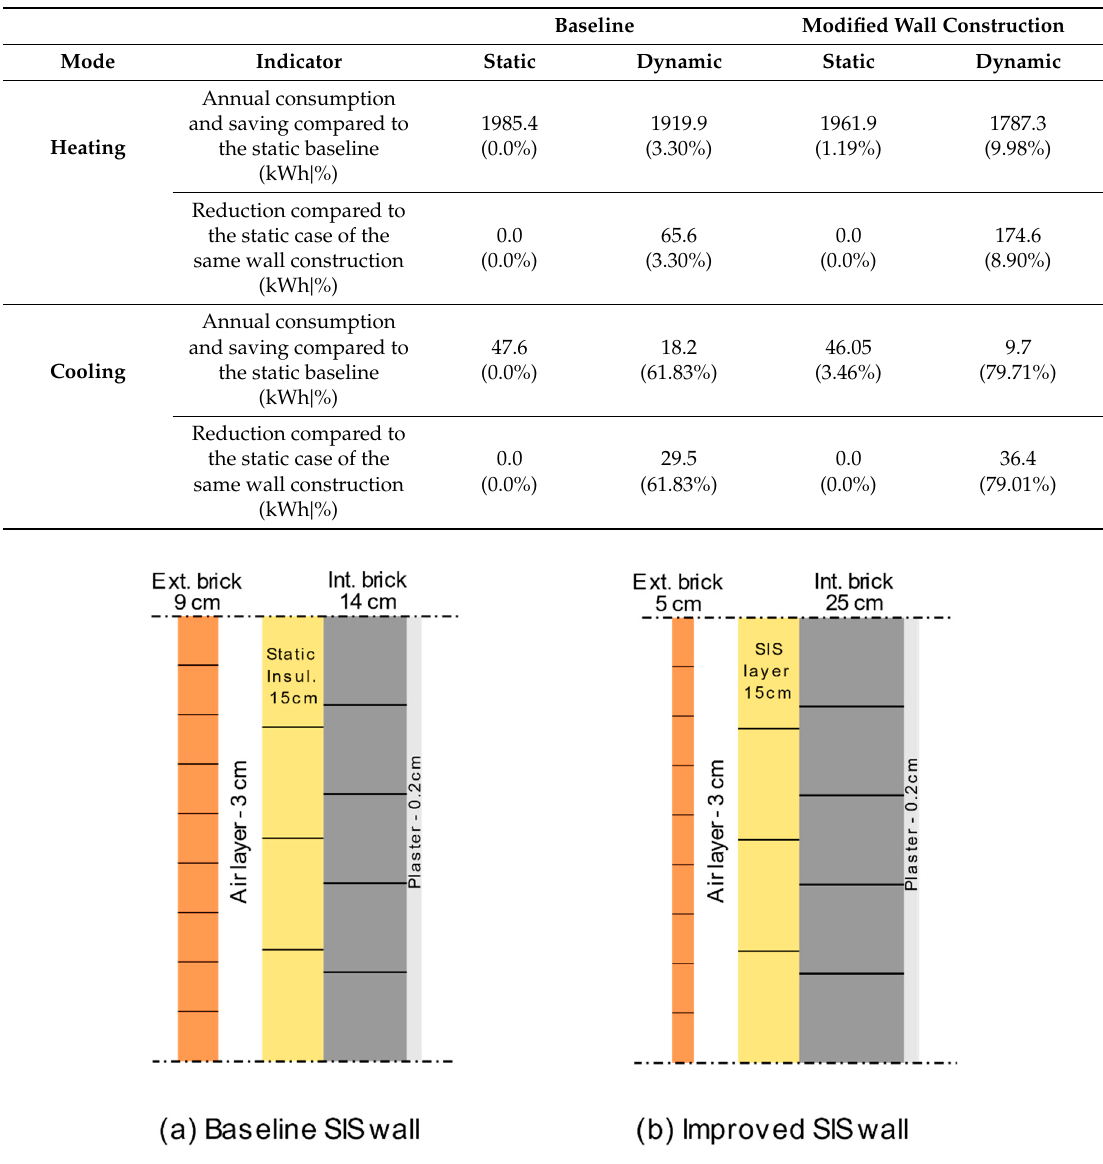
Table 9. Comparison of annual heating and cooling energy consumption for improved thicknesses and densities of the interior and exterior brick layers for the walls of the prototypical Belgian apartment.